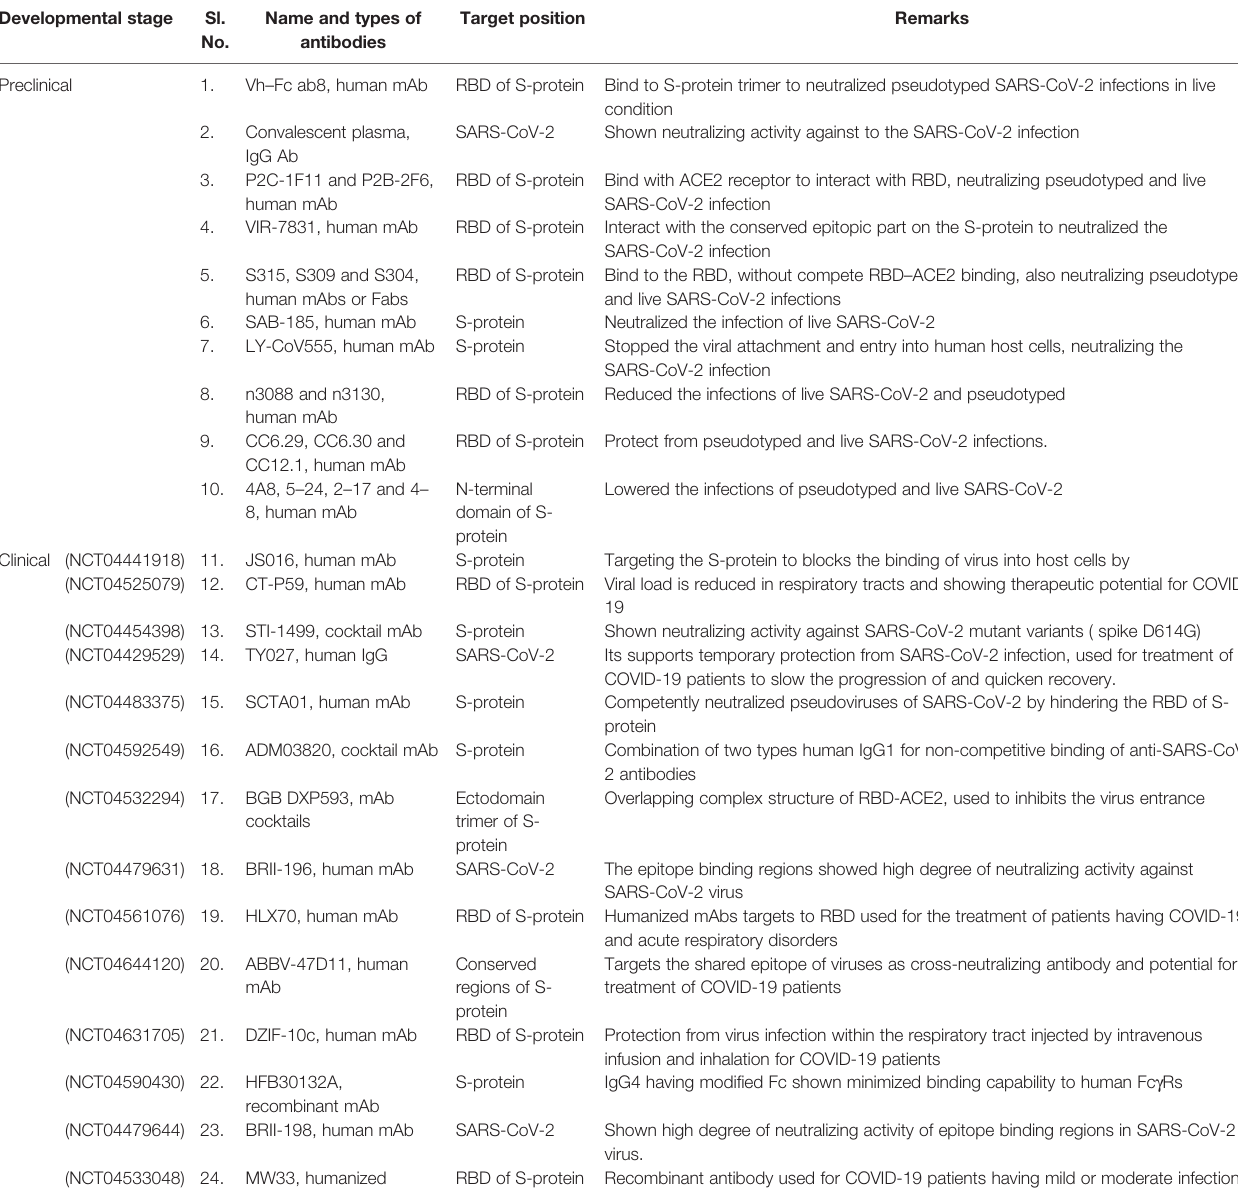
TABLE 3 | Monoclonal antibodies (mAbs) developed against SARS-CoV-2 for therapeutic purpose which are in preclinical and clinical trial stages. Sl.